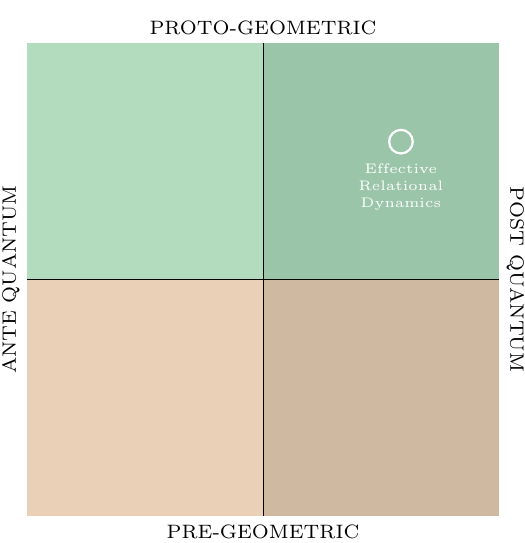
Figure 1 . The four possible contexts for relational dynamics in emergent theories of quantum gravity. Besides the classical choice of quantizing before or after having chosen a quantum clock, the emergent perspective adds another layer: defining relational dynamics in a pre-geometric or in a proto-geometric phase of the theory. The preferable choice (both for practical and conceptual reasons) is to define an effective and emergent notion of relational dynamics in the upper right side of the diagram, but as an effective description of states and observables defined in the lower right